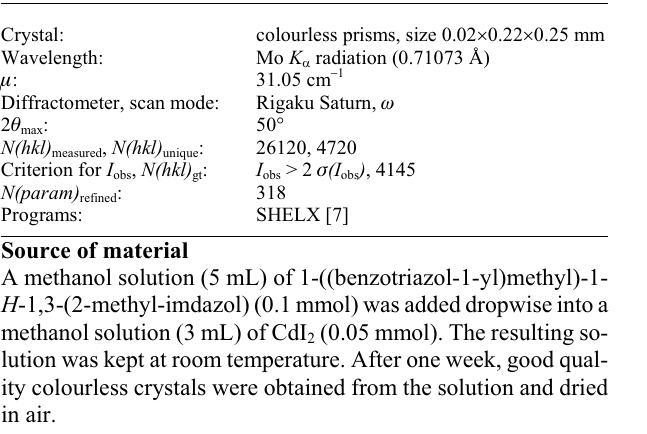
Table 1. Data collection and handling.